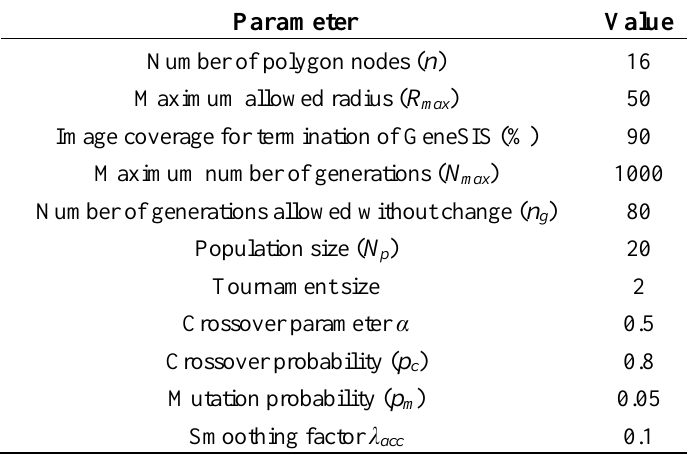
Table 1. Parameters used in